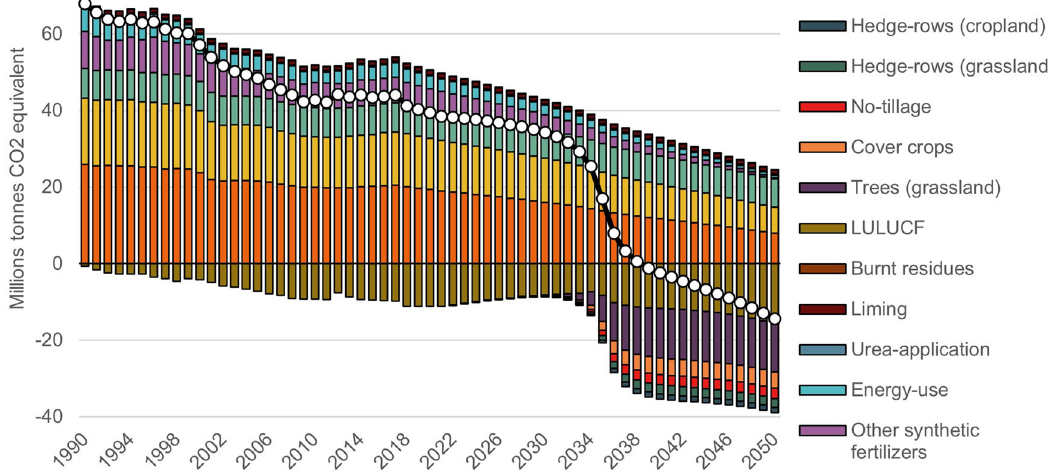
Fig. 4 Evolution of the food and agriculture system related GHG emissions in the UK from 1990 to 2050 in the EEB pathway(MtCO2eq). The GHG sources have been aggregated for a better visibility, and to match the common reporting format 19